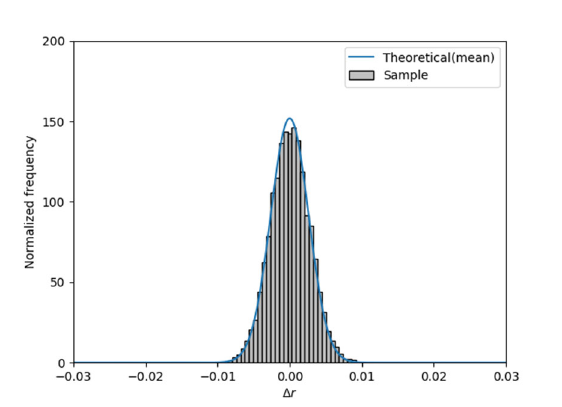
Fig. 9. Histogram of 𝛥𝑟 (when 𝐕(cid:3553) 𝐦 (cid:3404) 𝑝 (cid:2870) (cid:3554)𝐕 𝐦 )